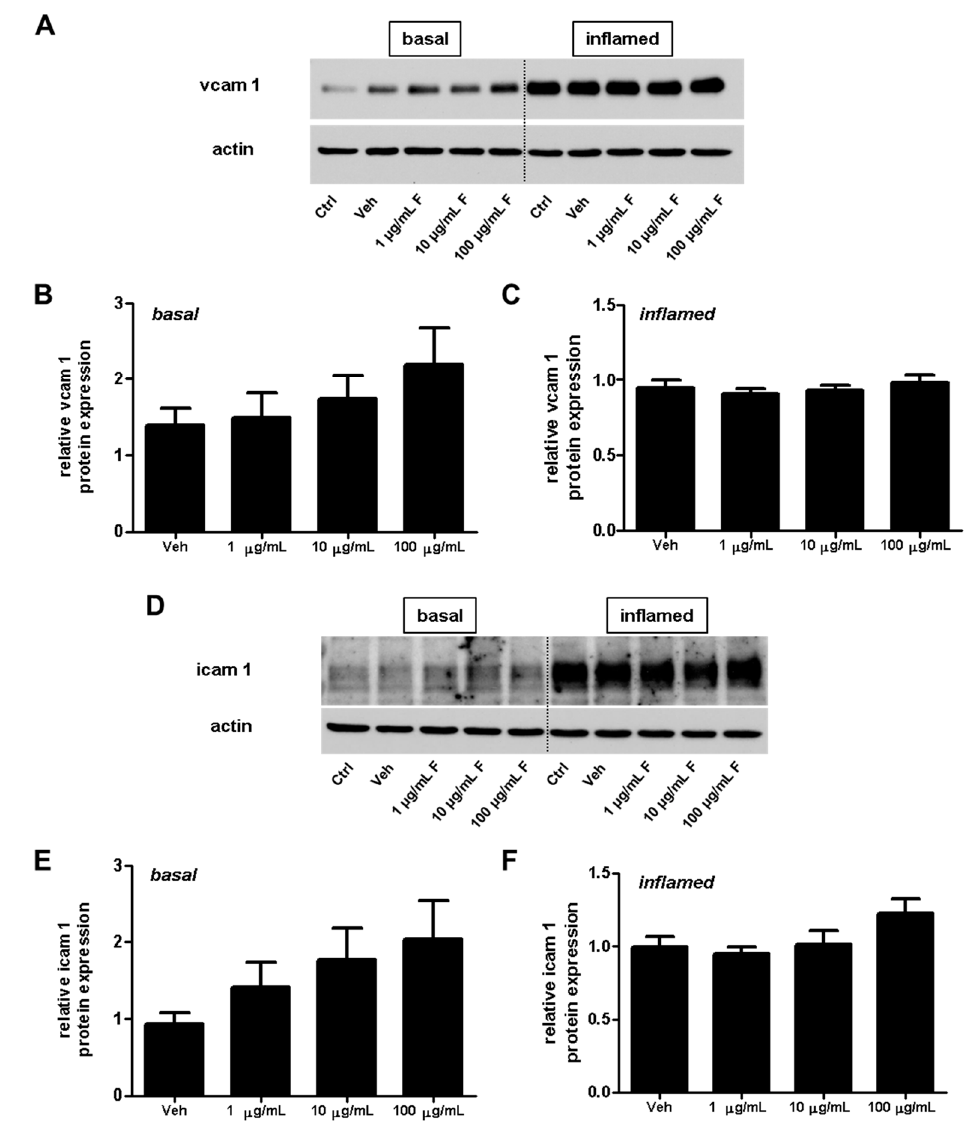
Figure 8. Effect of fullerenols on the amount of adhesion molecules in mouse brain microvascular endothelial cell (MBMEC) cultures under basal and inflammatory conditions. Western blot analysis and densitometric quantification (normalized to basal or inflamed untreated control cell cultures) of the amount of VCAM-1 ( A – C ) and ICAM-1 ( D – F ) proteins in MBMECs after exposure to interferon- γ and tumor necrosis factor- α (I + T; 100 IU each) ( C , F ), and treatment with fullerenol (F; 1, 10 and 100 µg/mL; n = 6) for 18 h compared to cultures under basal (homeostatic milieu) conditions ( B , E ). β -Actin was used as loading control. Ctrl, untreated control; Veh, vehicle treatment.